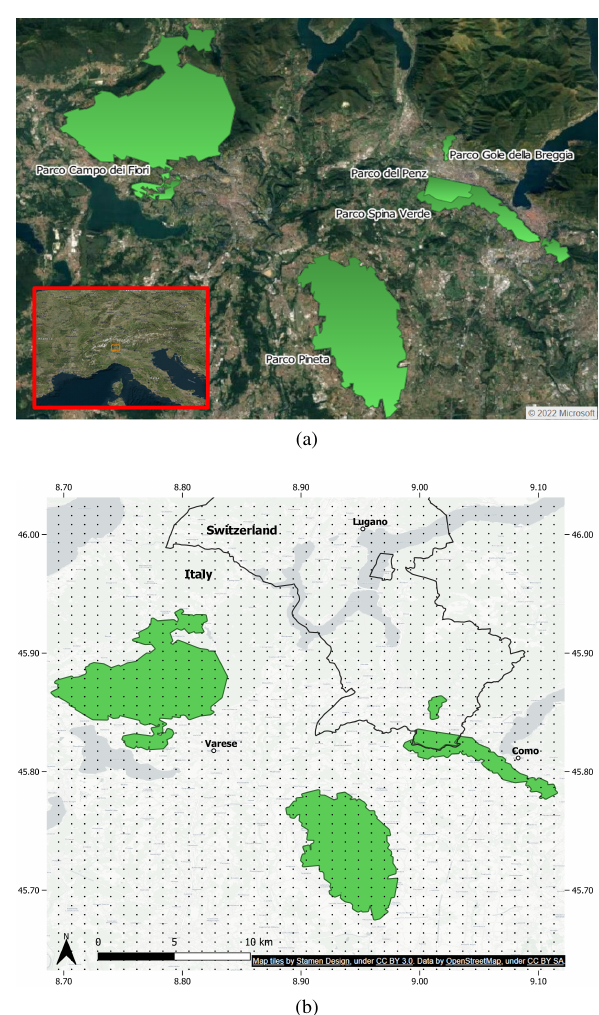
Figure 1. The natural parks of the Insubria Region (a) and the Bing tile grid centres position for the study region with the main urban centres (b). Basemaps: (a) Bing Satellite © 2022 Microsoft, (b) Map tiles by Stamen Design, under CC BY 3.0. Data by OpenStreetMap, under CC BY